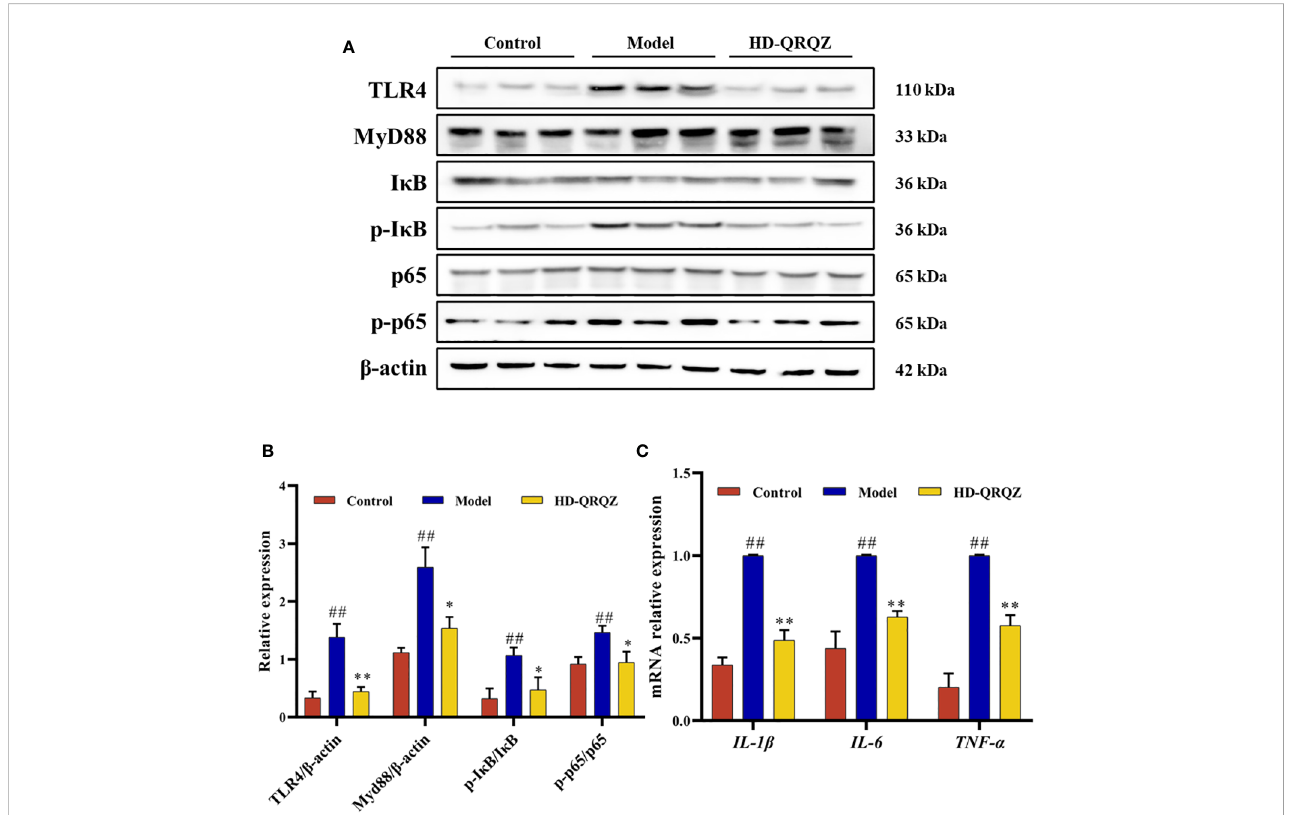
FIGURE 5 Effects of QRQZ on TLR4/NF- k B signaling pathway and mRNA expression of pro-in fl ammatory cytokines in liver. (A, B) The protein expression of TLR4, MyD88, I k B, p- I k B, p65, p- p65 in liver was detected by western blot. (C) mRNA expression of pro-in fl ammatory cytokines ( IL-1 b , IL-6 and TNF- a ) in liver was investigated using qPCR. Control, Model and HD-QRQZ (n = 3 per group) groups. Data are presented as the mean ± standard deviation. ## P < 0.01 as compared to the Control group; * P < 0.05 as compared to the Model group; ** P < 0.01 as compared to the Model